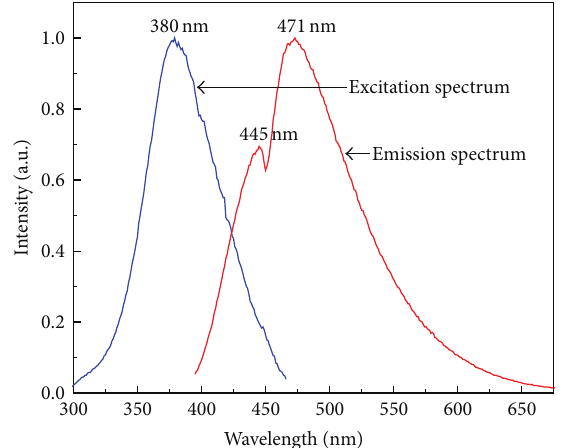
Figure 1: Normalized excitation spectrum and emission spectrum of vinegar-water